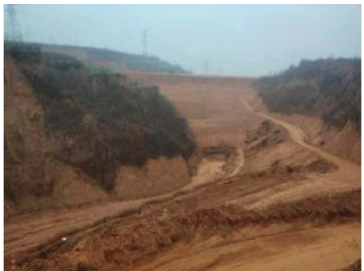
Figure 2: Loess high-fill embankment.